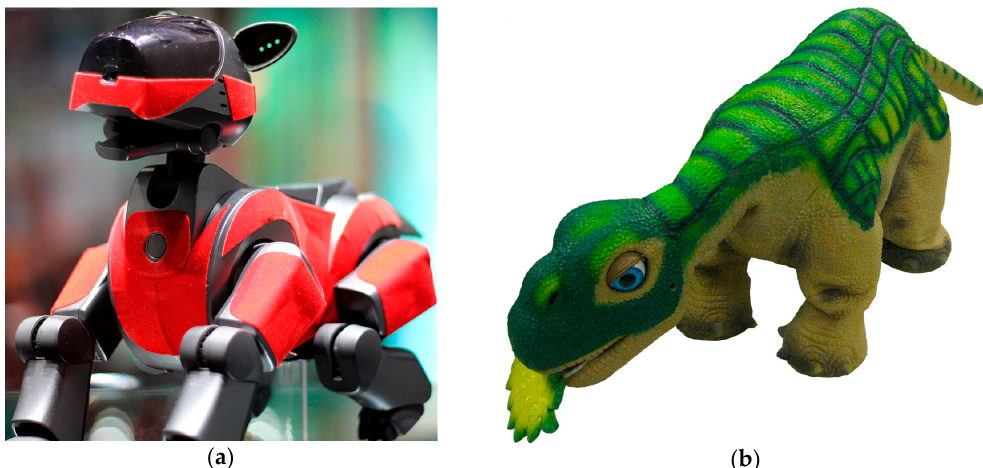
Figure 3. Other robotic domestic technologies: ( a ) AIBO by Sony. Image by Sven Volkens. CC BY-SA 4.0; https://commons.wikimedia.org/wiki/File:Aibo-DASA.JPG. Cropped and resized to fit; ( b ) Pleo robot (by Ugobe). Image by Jiuguang Wang. CC BY-SA 3.0; https://commons.wikimedia.org/wiki/File: Pleo_robot.jpg; Cropped and resized to